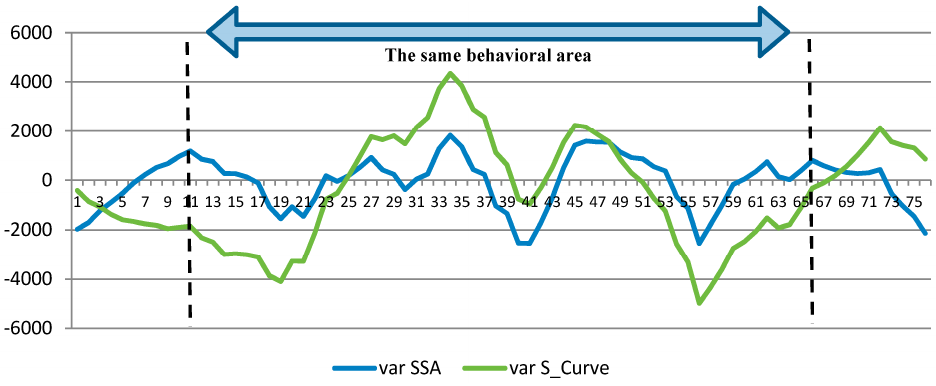
Figure 15. Deviations between the SSA trend and the S-curve method with the generated time series.